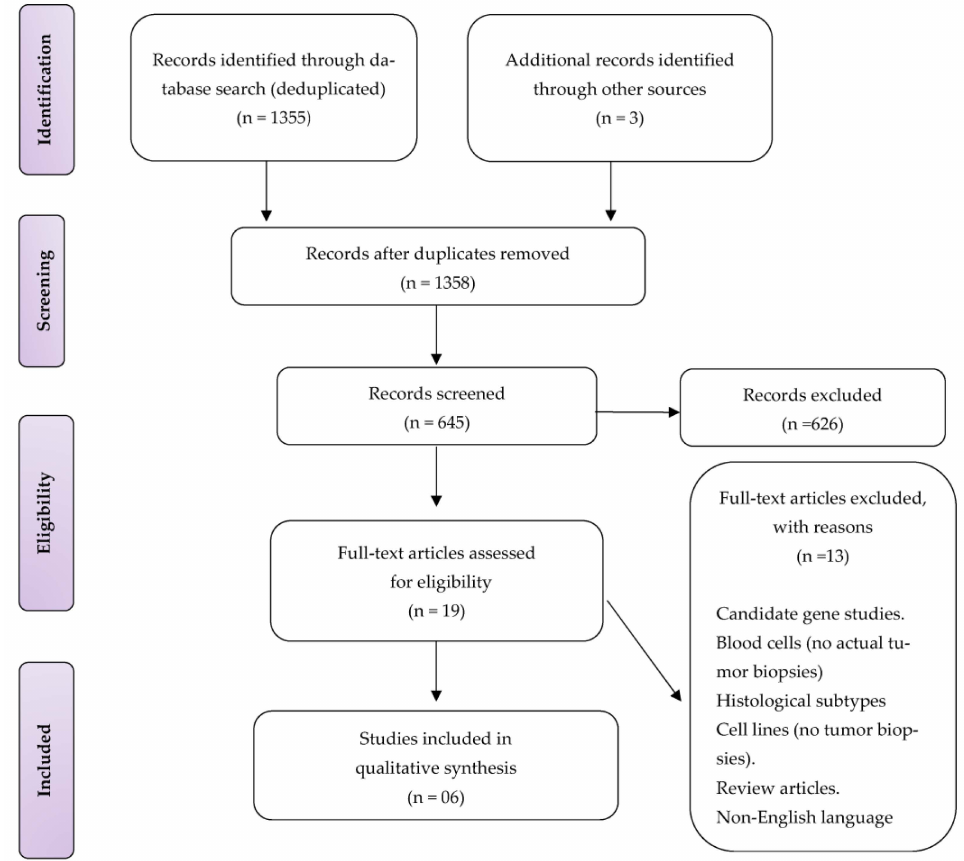
Figure 1. PRISMA flow diagram showing a selection of included